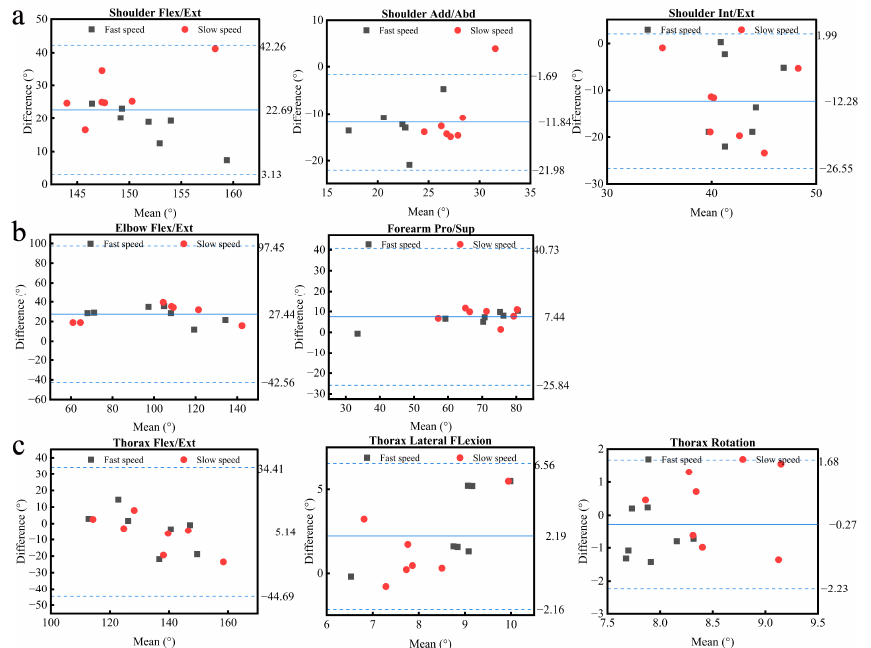
Figure 3. Bland–Altman plots for each absolute angular of the shoulder ( a ), elbow ( b ), and trunk ( c ) in the complex task. The solid blue horizontal line stands for the mean bias, while the dashed blue horizontal lines indicate the upper and lower 95% confidence intervals. Note that Add/Abd, Flex/Ext, Int/Ext, and Pro/Sup stand for adduction/abduction, flexion/extension, internal/external rotation, and pronation/supination, respectively. Table 1. The statistical metrics of validity and reliability of the PNS in simple